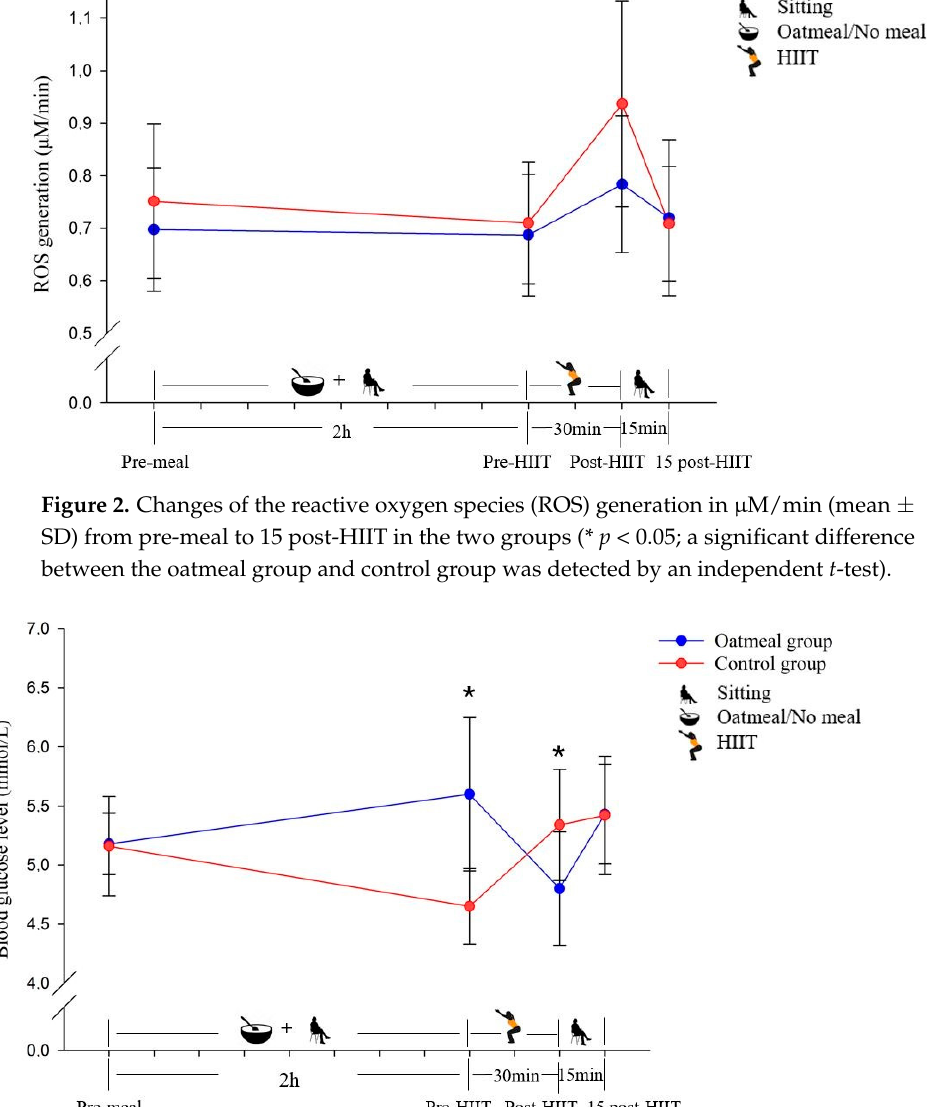
Figure 3. Changes of the blood glucose level in mmol/L (mean ± SD) from pre-meal to 15 post-HIIT in the two groups (* p < 0.05; significant differences between the oatmeal group and control group were detected by an independent t -test). Table 1. Nutritional composition of the